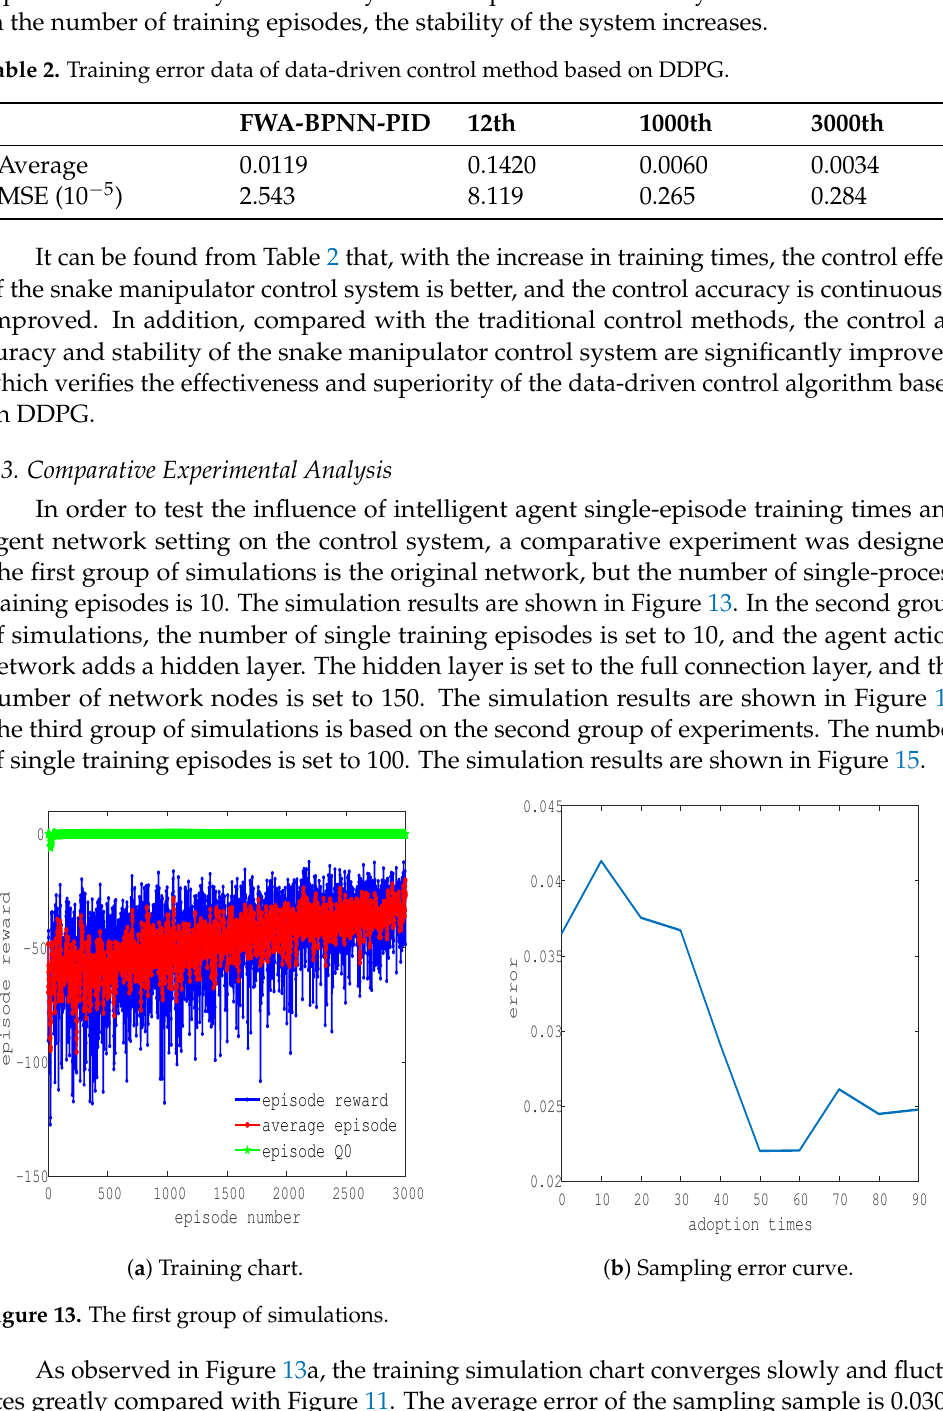
Figure 13. The first group of